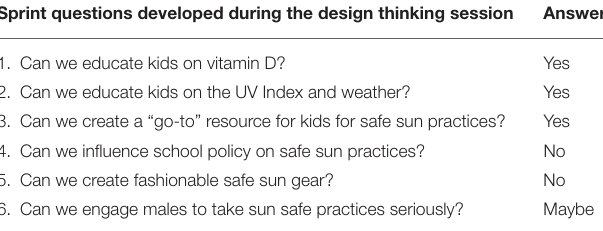
TABLE 1 | Sprint questions developed in design thinking